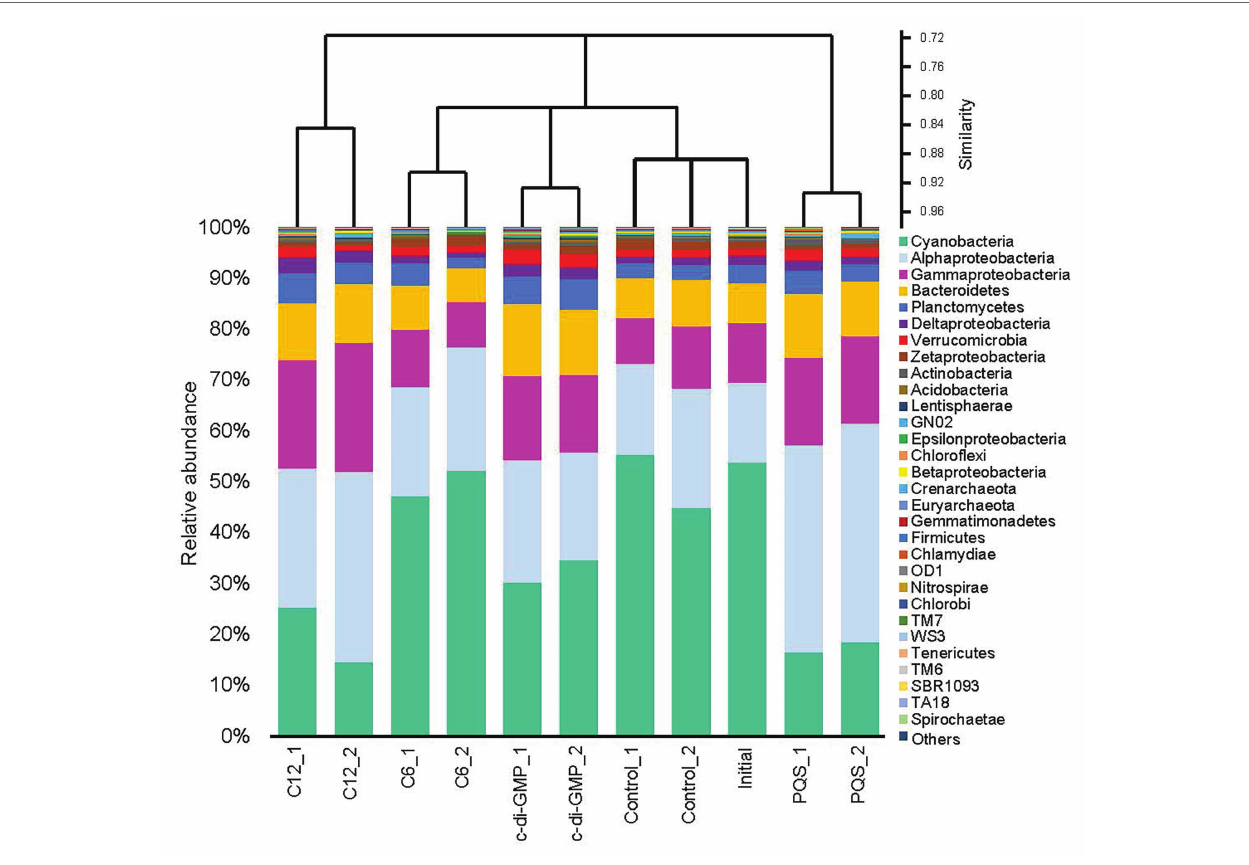
FIGURE 1 | Phylum-level composition of the biofilms in the signal molecules treatment experiment. Biofilms that had been growing for 9 days in the subtidal zone of Hong Kong waters were collected and subjected to different signal molecules treatments in the laboratory. Then, the genomic DNA of each biofilm sample was sequenced for metagenomic analysis. The biofilms treated with seawater were labeled as “control,” and the untreated biofilm was labeled as “initial.” Except for the “initial” biofilm, each treatment had two biological replicates. Proteobacteria were classified down to the class level. The 30 most abundant taxa (ranked by maximum abundance) are shown, and the other taxa are included under the classification of